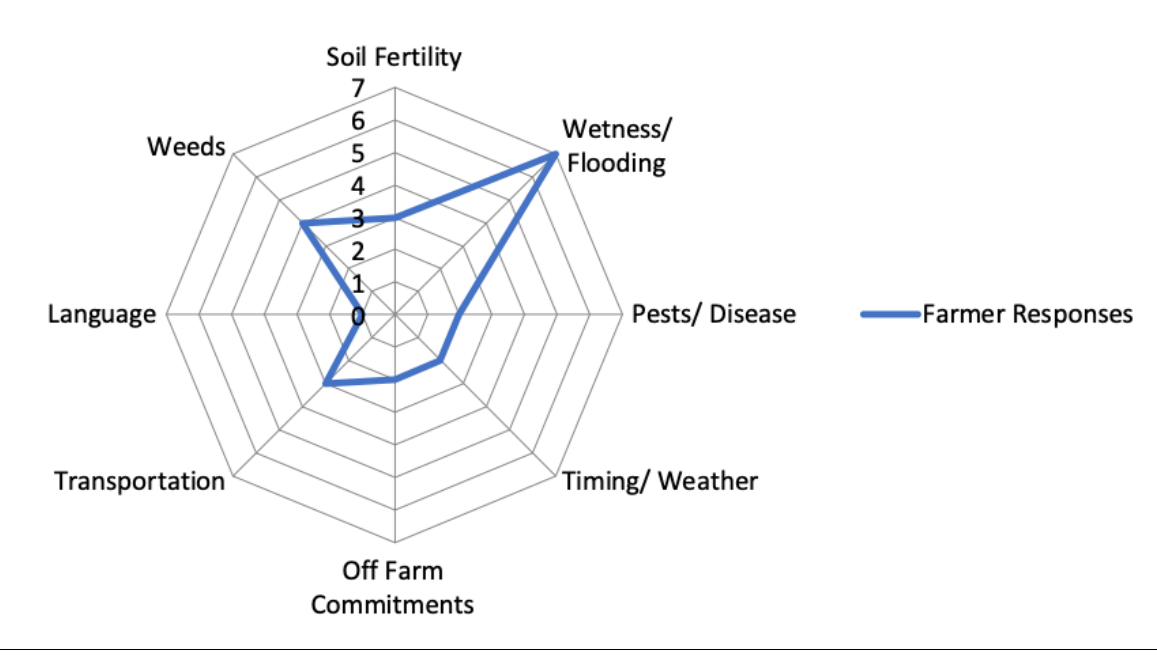
Figure 1. Farmer-Identified Production Barriers